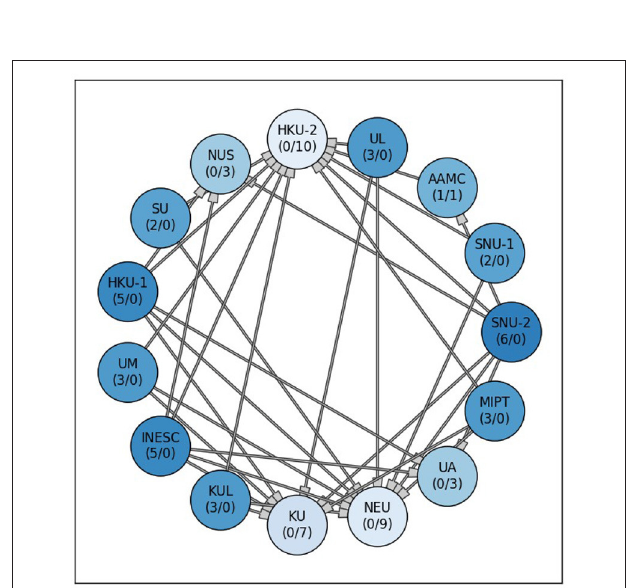
FIGURE 6 | Significant differences between the 15 submitted methods at ISLES 2017. Each node stands for one participating team. A connection between two nodes represents a significant difference between both lesion prediction models, whereas the methods at the tail side was superior. The stronger or weaker a models the more outgoing or incoming connections (#outgoing/#incoming), are associated with a team’s node. Additionally, the node color saturation indicates the strength of a method, with better methods appearing more saturated. Differences between methods were assessed via non-parametric ANOVA with repeated measurements (Friedman test) and subsequent, pair-wise comparison with Dunn test ( p < 0.05).